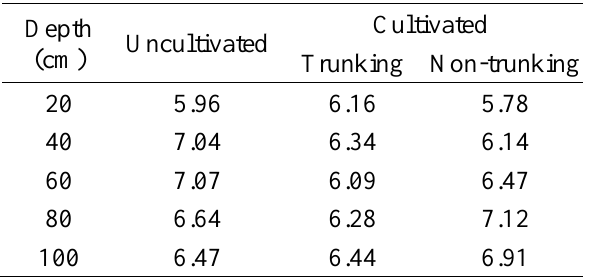
Table 2. The E /E values of humic acid extracted 4 6 from uncultivated and cultivated peat, according to depth.